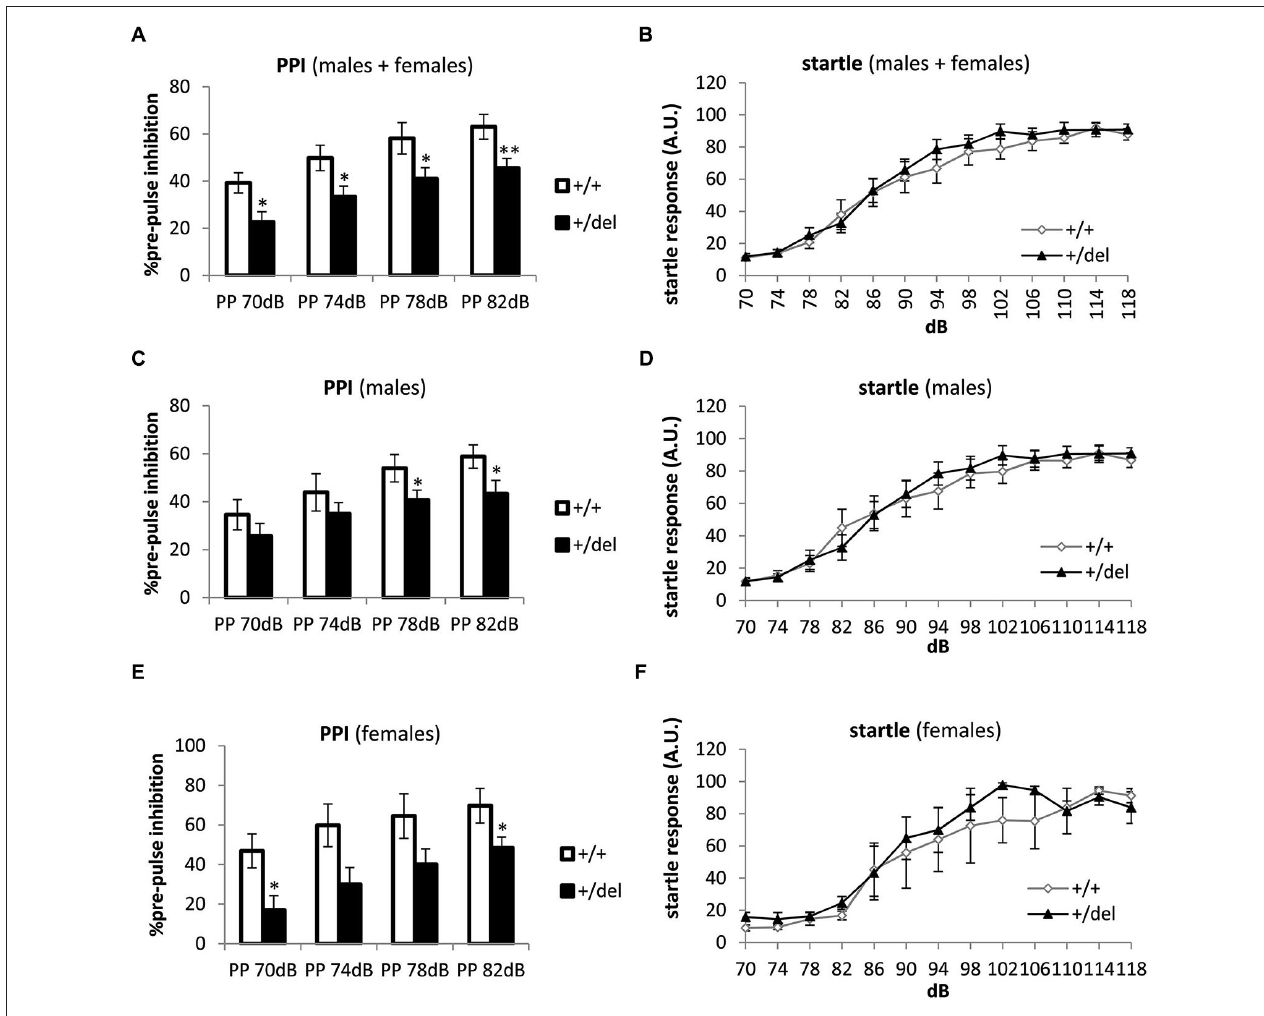
sound intensities: 70, 74, 78, 82, 86, 90, 94, 98, 102, 106, 110, 114 and 118 dB. Males and females (B) , males (D) and females (F) . * Correspond to analysis of each pre-pulse intensity separately (although two-way repeated measures ANOVA was also performed); * p < 0.05, ** p < 0.01.